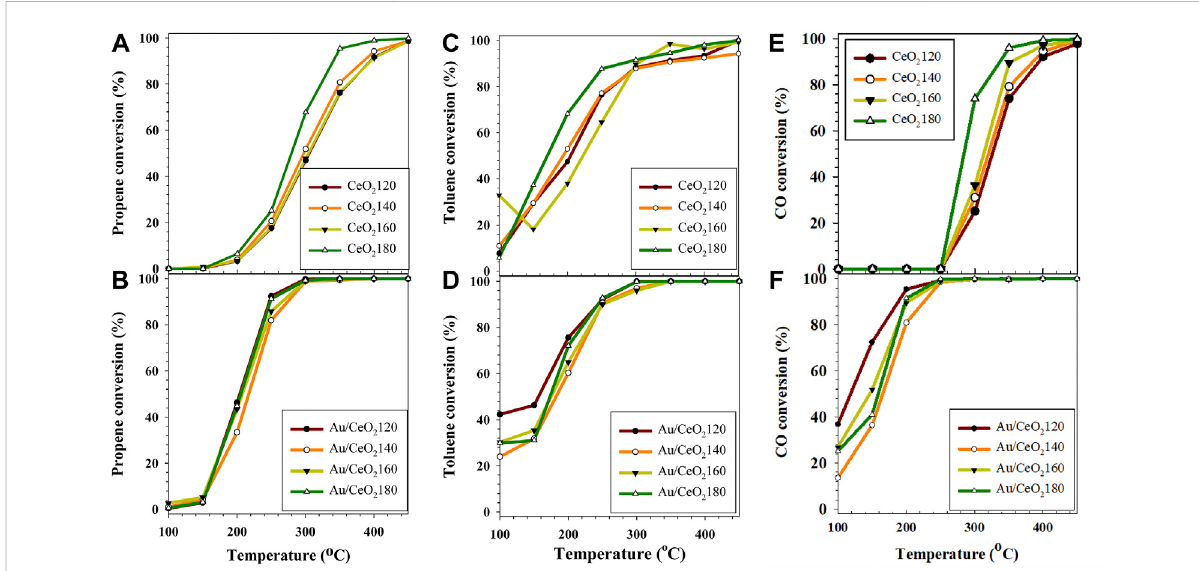
FIGURE 9 Catalytic activities of the CeO 2 X and Au/CeO 2 X catalysts for the oxidation of a propene/toluene/CO mixture at a gas hourly space velocity of 50,000 h − 1 represented in terms of conversion level (%) of (A,B) propene (C,D) toluene, and (E,F) CO. CeO 2 X: cerium oxide obtained at a value X for the temperature of the preparatory hydrothermal process; Au/CeO 2 X: CeO 2 X-supported gold catalysts.